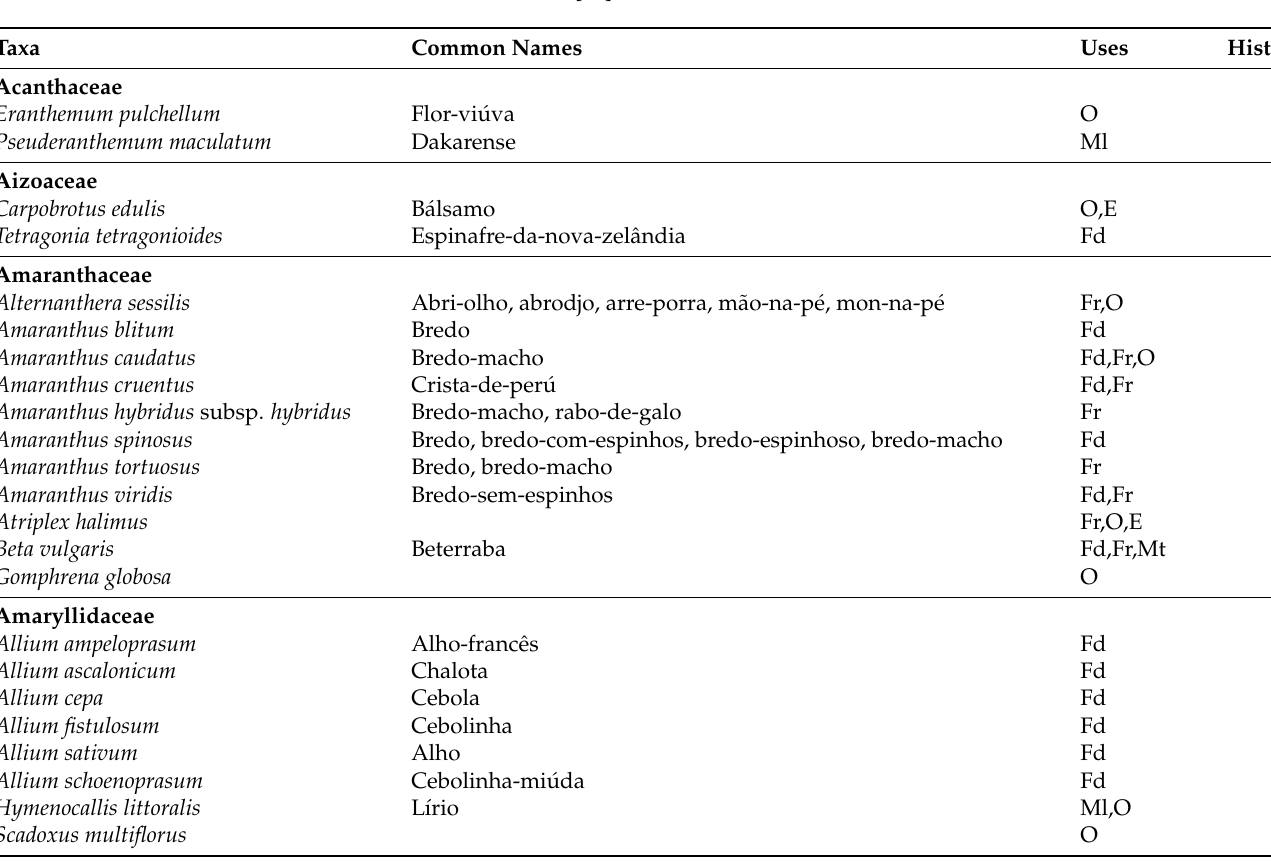
Table 2. Introduced useful taxa occurring in Cabo Verde, including information on family, common names (mostly in creole), main uses (Fd, food; Fr, forage; Ml, melliferous; P, poison; S, social uses; Fu, fuelwood; T, timber; U, utilitarian uses; Mt, materials; O, ornamental; E, environmental use; for details, see Materials and Methods), and historical use (Hist.). Taxonomic authorities according to Plants of the World Online